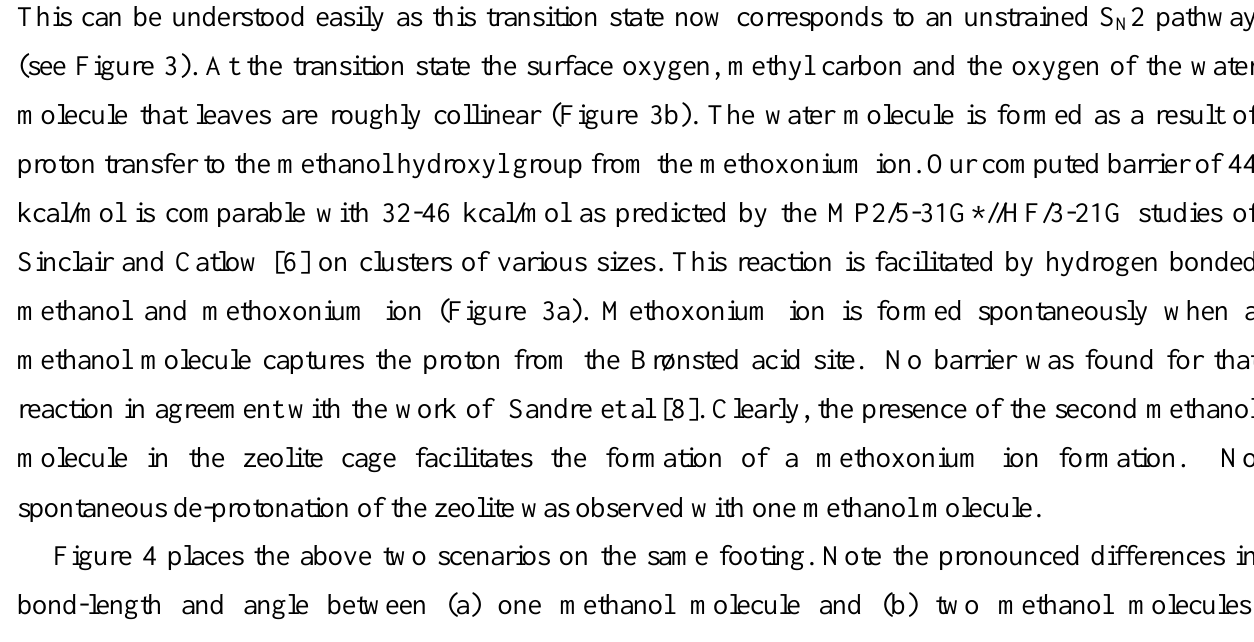
2 type reaction. N